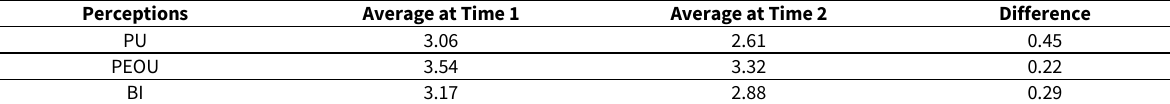
Table 9. Averages of students perceptions of usefulness, ease of use, and behavioral intention– Time 1 and 2 Perceptions